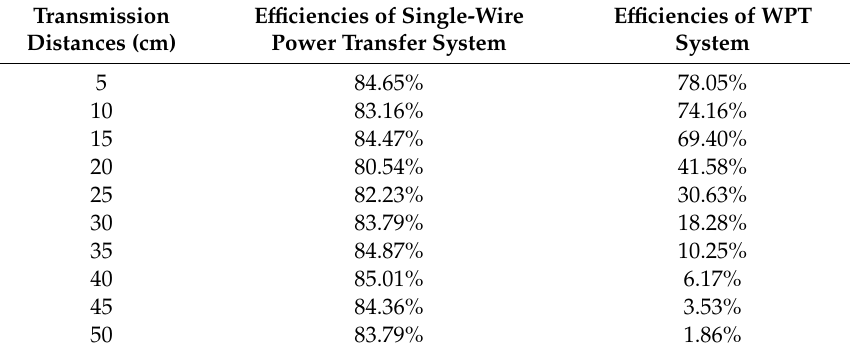
Table 2. Results of comparative experiments.